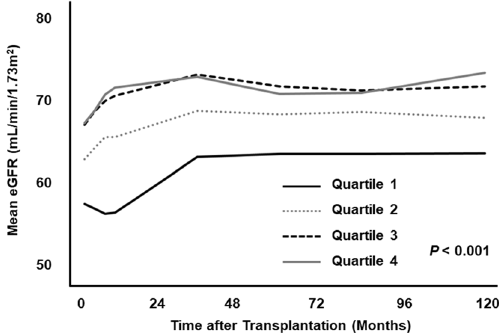
Figure 5. Changes in graft function according to serum bilirubin